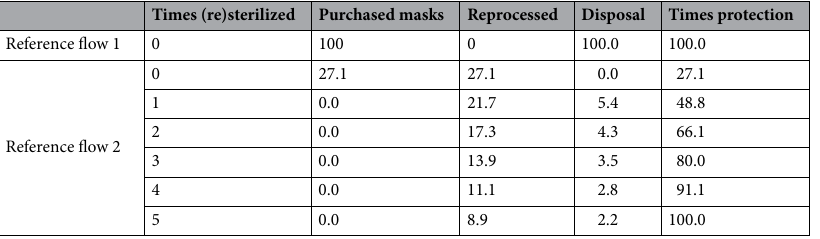
Table 1 shows the differences between the two scenarios: